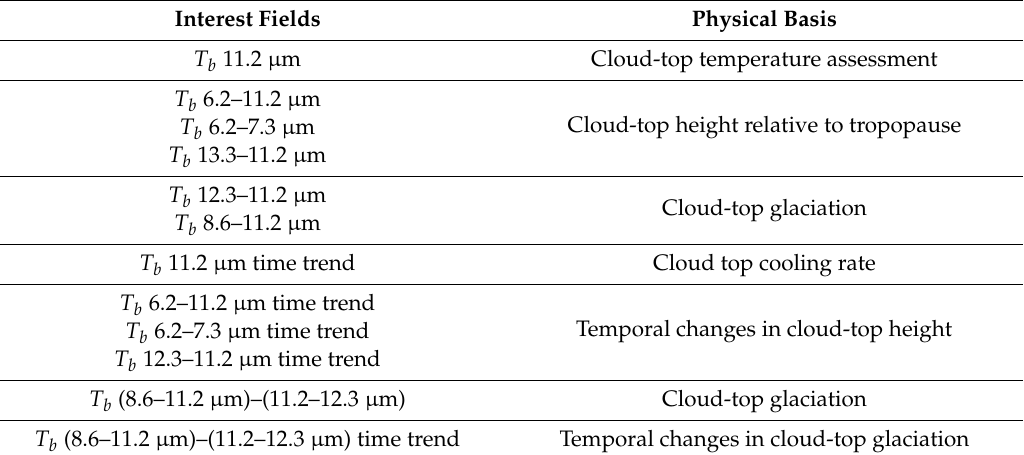
Table 2. Interest fields used in this framework for CI detection (Lee et al.